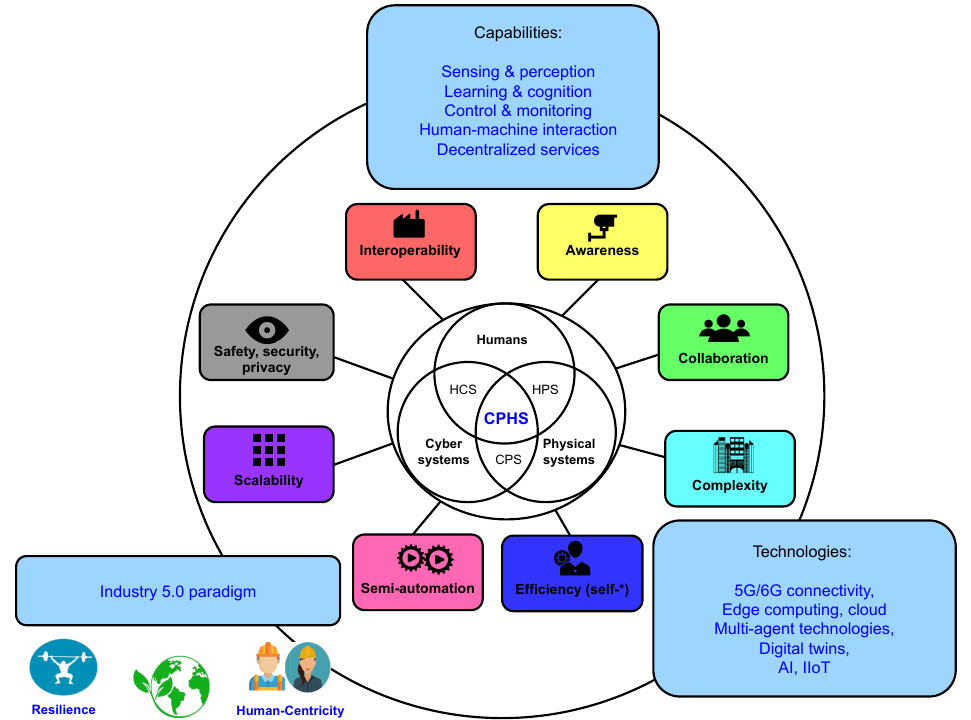
Figure 1. Main attributes of an Industry 5.0